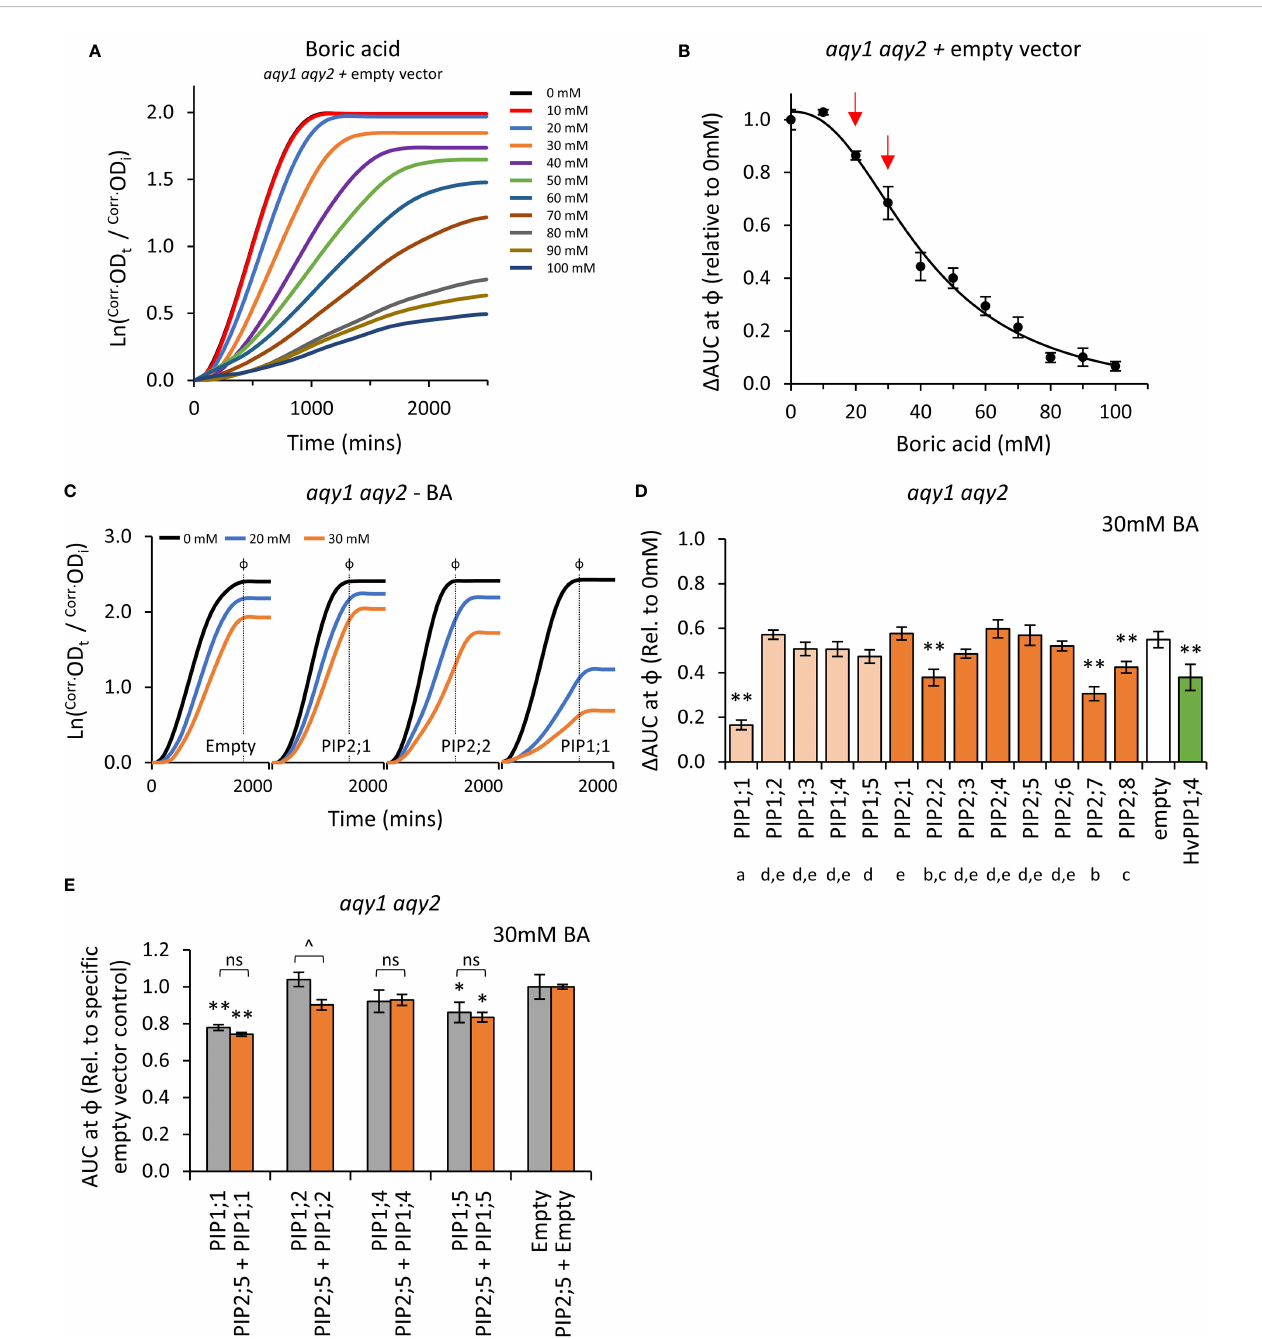
FIGURE 6 Boric acid permeability assays. (A) , Growth curves for aqy1 aqy2 yeast exposed to increasing concentrations of boric acid (BA). (B) , Dose response curve of relative AUC as a function of boric acid concentration. Red arrows denote BA concentrations chosen for testing yeast expressing AtPIP . (C) , Example growth curves for aqy1 aqy2 yeast expressing AtPIP genes exposed to 0, 20 or 30mM boric acid (BA). (D) , Relative AUC for aqy1 aqy2 yeast expressing each AtPIP gene exposed to 30mM boric acid, with HvPIP1;4 as a boric acid permeable control. E, Relative AUC for aqy1 aqy2 yeast expressing AtPIP1 singly (grey) or together with AtPIP2;5 (orange) at 30mM boric acid. Each set is standardized to their respective empty vector control. All error bars are SEM. For (D) , asterisks indicate statistical difference from empty vector control, ANOVA with Fishers LSD test (* P < 0.05; ** P < 0.01); letters denote different statistical rankings across both 20 and 30mM boric acid, ANOVA with Tukey ’ s test ( P < 0.05). For (E) , asterisks indicate statistical difference from respective empty vector control, ANOVA with Fishers LSD test (* P < 0.05; ** P < 0.01); chevrons (^) indicate statistical difference between single vs. co- expression (Student ’ s t test P < 0.01). For D and E, N = 6 across 3 experimental